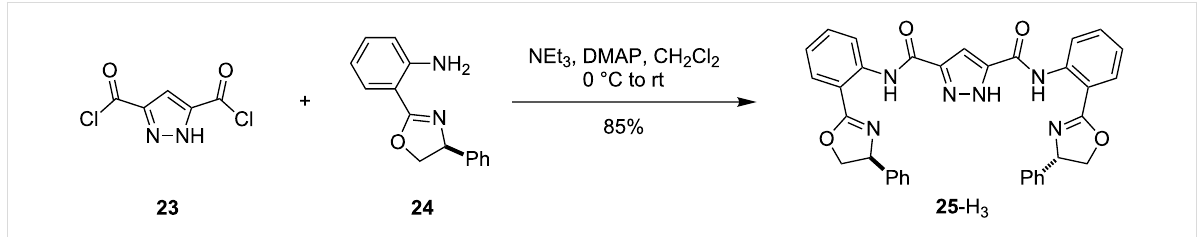
Scheme 2: Synthesis of naphthyridine–bisoxazoline ligand 22 -H 2 .